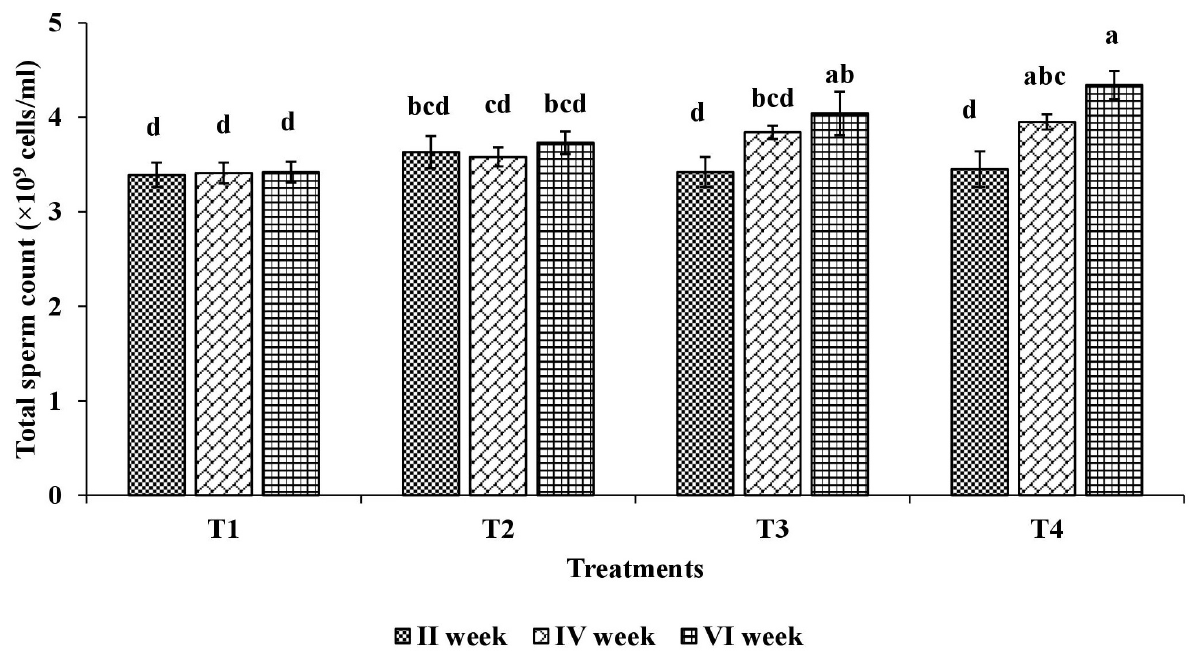
Figure 1. Effect of soapnut shell powder (SSP) supplementation on total sperm count in male broiler breeders (T×P interaction). T1, control group; T2, control+SSP at 0.0176%; T3, control+SSP at 0.026%; T4, control+SSP at 0.0528%. Bars with different superscripts differ significantly